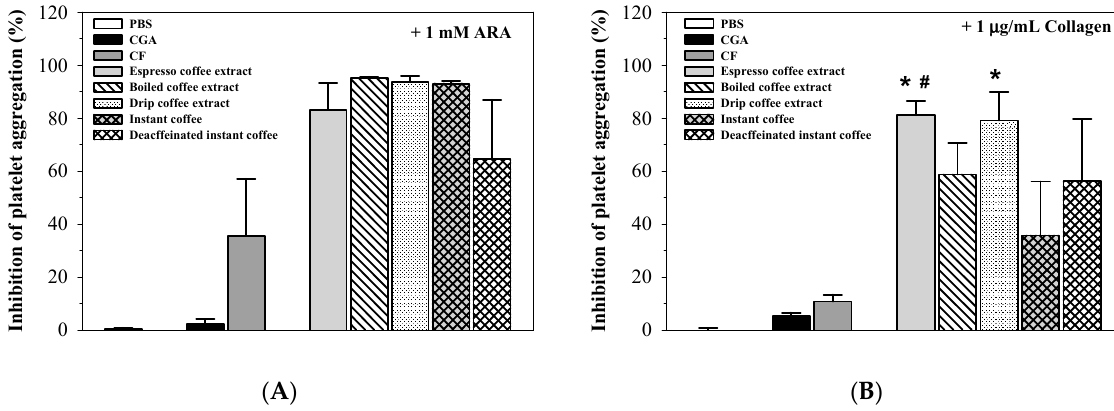
Figure 4. Inhibitory effects of phosphate-buffered saline (PBS), coffee extracts (0.5 and 1 mg/mL each), 18.23 mg/mL chlorogenic acid (CGA) and 54.17 mg/mL caffeine (CF) on aggregation of platelets induced by collagen ( B ) and sodium arachidonate (ARA) ( A ). Data obtained from five blood samples are expressed as mean + SEM values. * p < 0.05 when compared with the CGA; # p < 0.05 when compared to the CF.